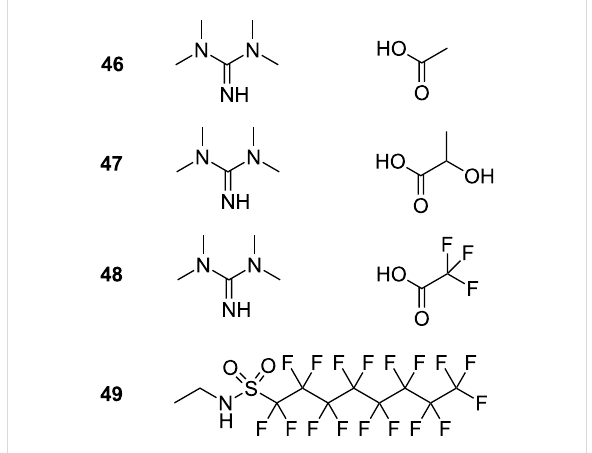
Figure 9: Structures of 1,1,3,3-tetramethylguanidinium acetate ( 46 ), 1,1,3,3-tetramethylguanidinium lactate ( 47 ), 1,1,3,3-tetramethylguani- dinium trifluoroacetate ( 48 ) and N -ethyl perfluorooctylsulfonamide ( 49 ), as used in IL-in-CO 2 microemulsions.